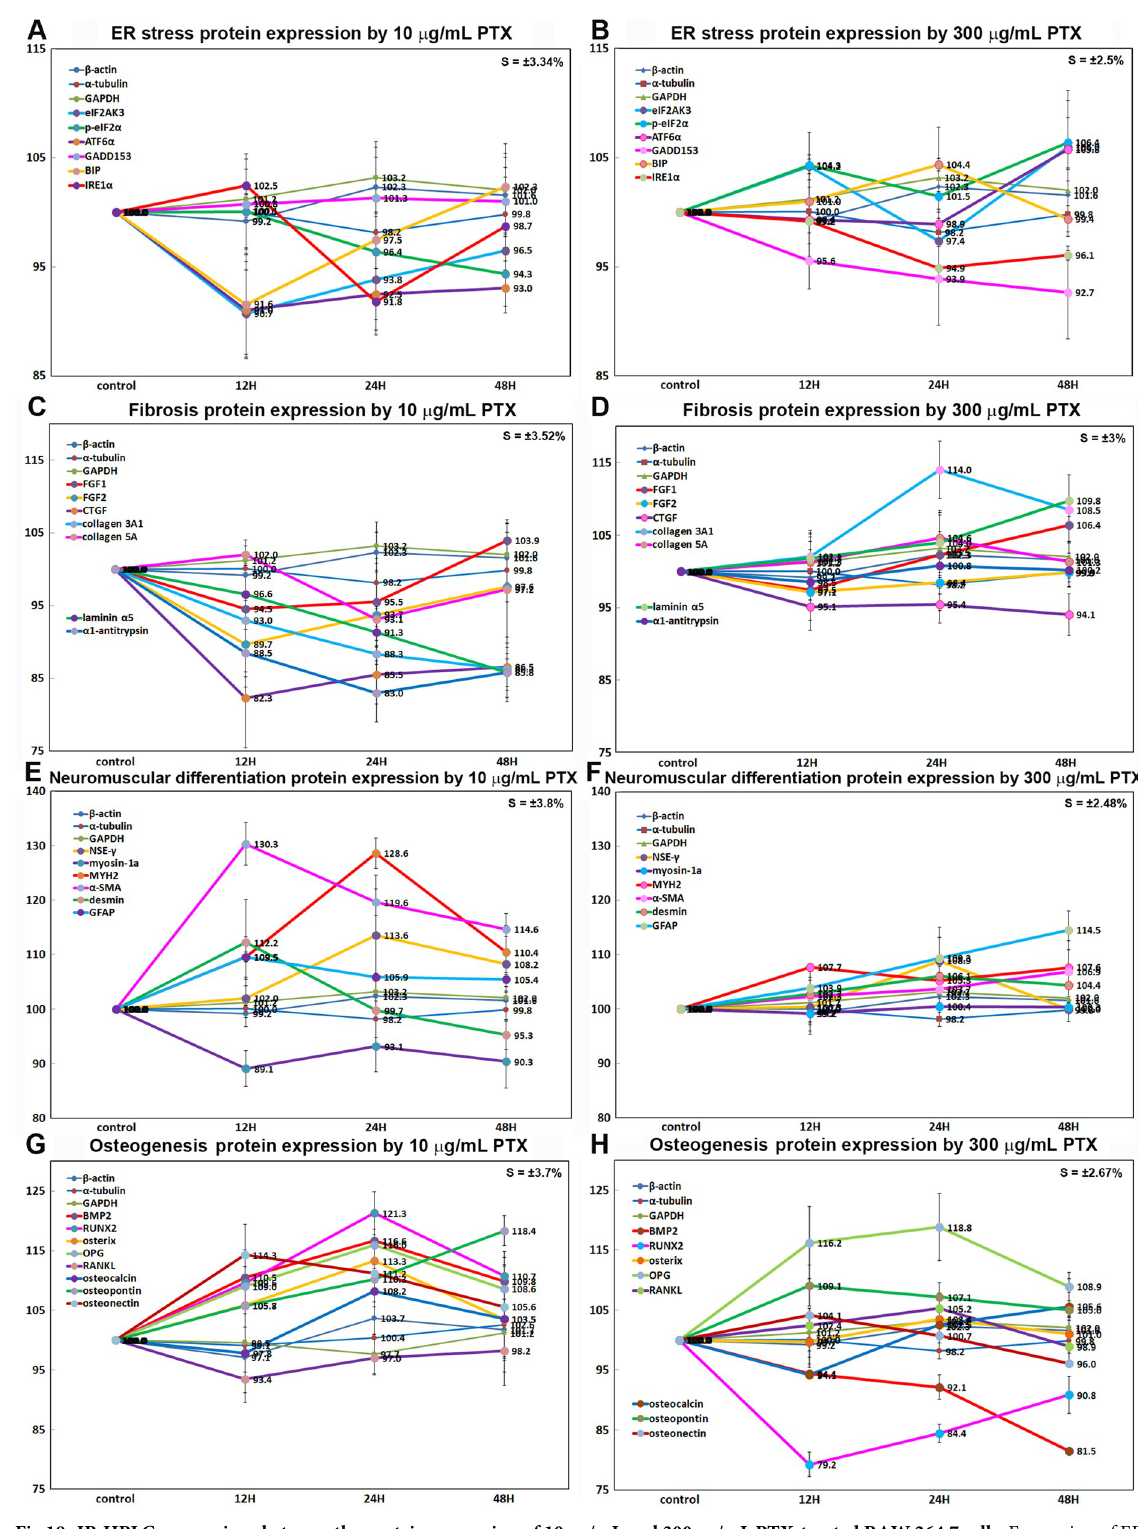
Fig 18. IP-HPLC comparison between the protein expression of 10 μ g/mL and 300 μ g/mL PTX-treated RAW 264.7 cells. Expression of ER stress proteins (A and B) fibrosis proteins (C and D), neuromuscular differentiation proteins (E and F) and osteogenesis proteins (G and H) as determined by IP-HPLC. Line graphs, A, C, E, and G show 10 μ g/mL PTX-induced protein expressions, whereas B, D, F, H show 300 μ g/mL PTX-induced protein expressions on the same scale (%) versus culture time (12, 24, or 48 h). https://doi.org/10.1371/journal.pone.0261797.g018 PLOS ONE | https://doi.org/10.1371/journal.pone.0261797 March 25,